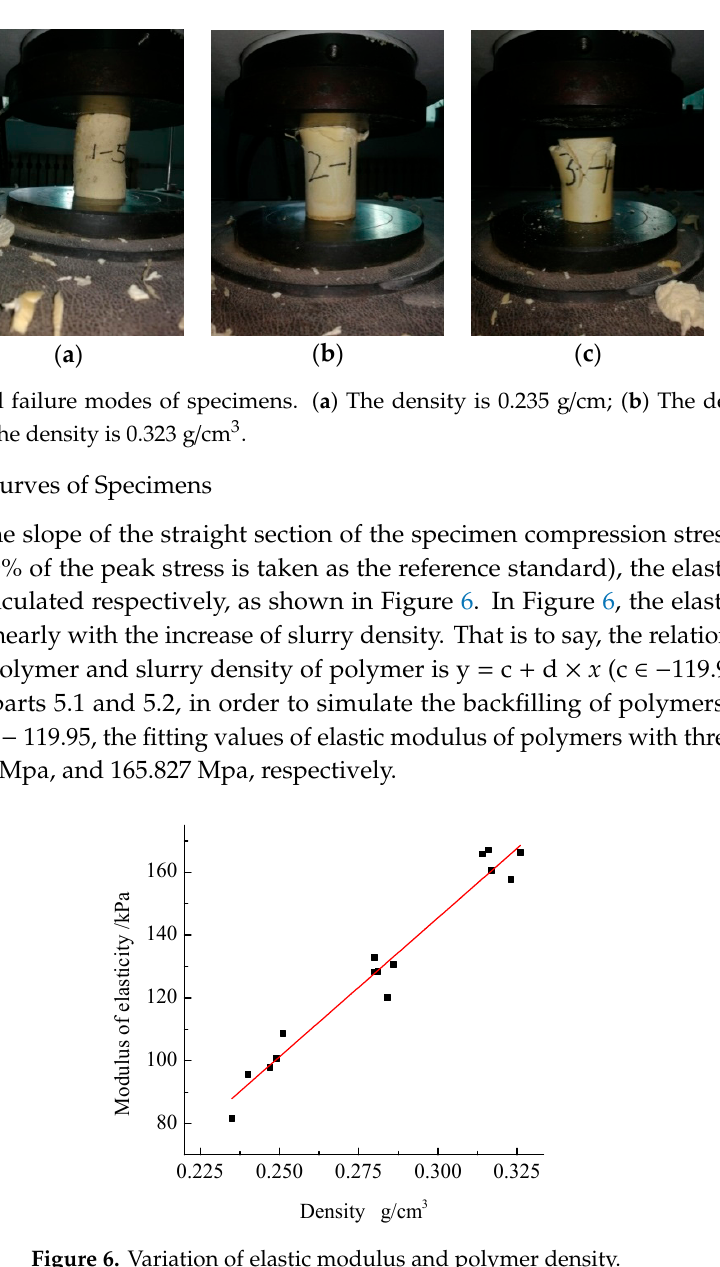
Figure 6. Variation of elastic modulus and polymer density.